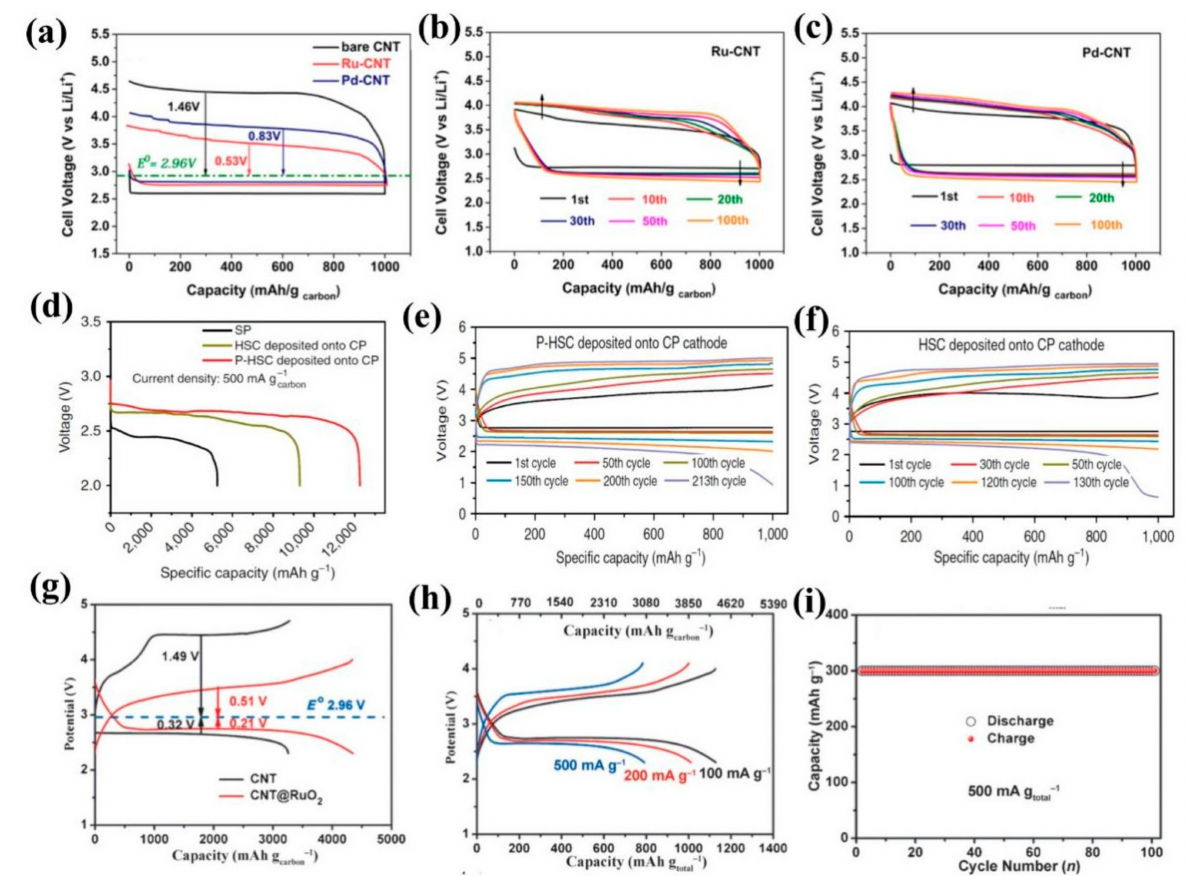
Figure 7. ( a ) Pristine CNT (black)s’ first cycle, Ru-CNT (red), and Pd-CNT (blue) cathodes and multiple cycles of the catalyzed Li-O 2 cells based on ( b ) Ru-CNT and (c) Pd-CNT cathodes at 1000 mA h g carbon − 1 . At 500 mA g carbon − 1 . Reprinted with permission from ref. [79]. Copyright 2016 American Chemical Society. ( d ) Rate performance of three cathode lithium oxygen batteries at current density of 500 mA g − 1 . ( e , f ) Discharge charge curve of lithium oxygen battery with P-HSC-HSC deposited on CP cathode under different cycles with 300 mA g − 1 and a cut-off capacity of 1000 mA h g − 1 , separately. Reprinted with permission from ref. [80]. Copyright 2016 Royal Society of Chemistry. ( g ) Discharge/charge profiles of the Li-O 2 batteries with the pristine CNTs (2.3–4.7 V) and CNT@RuO 2 composite at a 385 mA g carbon − 1 ( h ). The first discharge/charge profiles of Li-O 2 batteries with CNT@RuO 2 . ( i ) Cycling stability of the Li-O 2 battery at 500 mA g carbon − 1 . Reprinted with permission from ref. [28]. Copyright 2016 John Wiley and